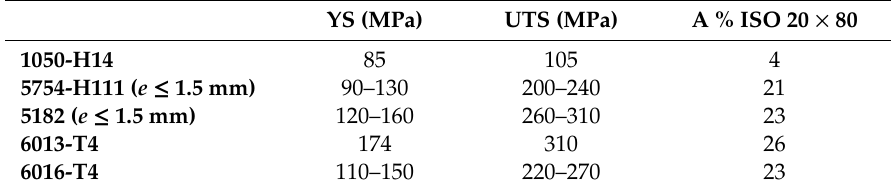
Table 5. Aluminum alloys’ mechanical